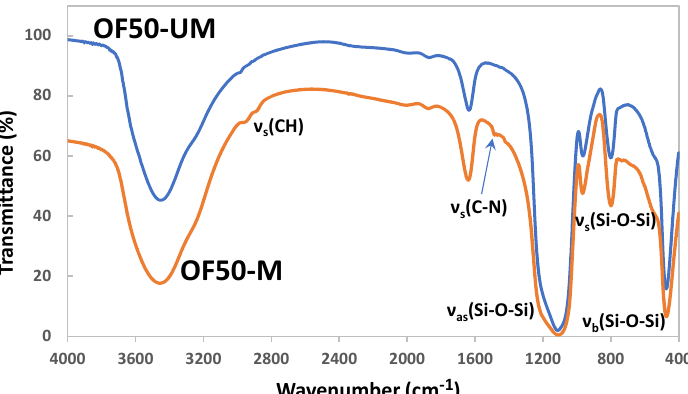
Figure 3. FTIR spectra of pristine OF50 (OF50-UM) and surface-modified/functionalized colloidal silica (OF50-M).